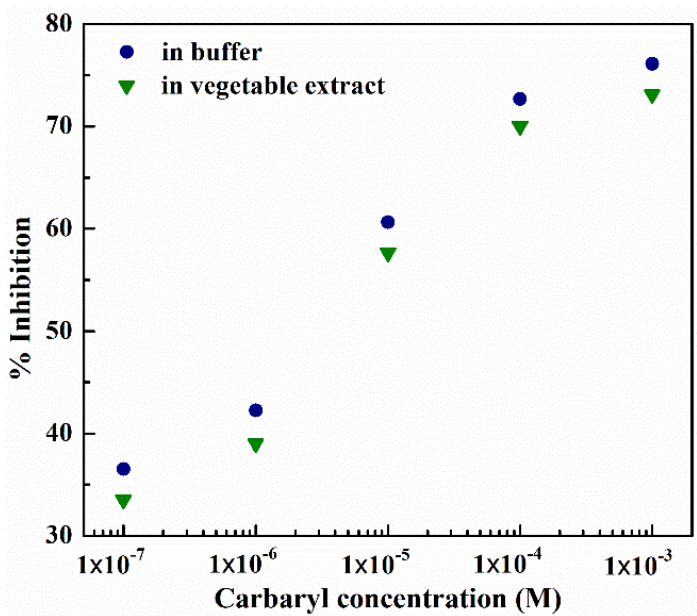
Figure 12. The percentage of enzyme inhibition of PBS- and vegetable extract-diluted carbaryl, given the solution temperature of 25 ◦ the solution temperature of 25 °C.